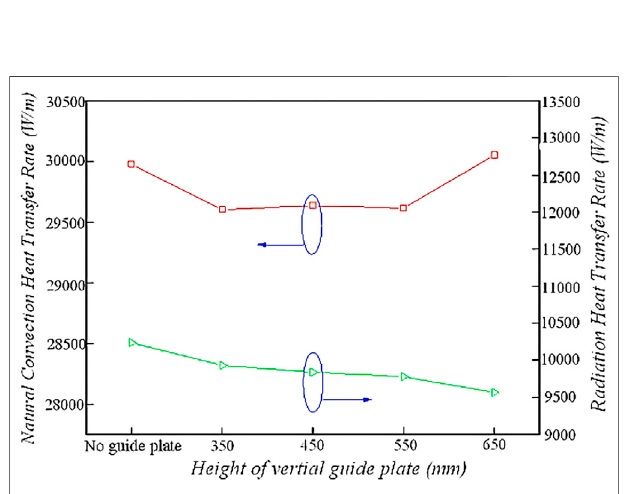
FIGURE 11 | Comparison of the rate of natural convection heat transfer and the rate of radiation heat transfer of vertical guide plates with various